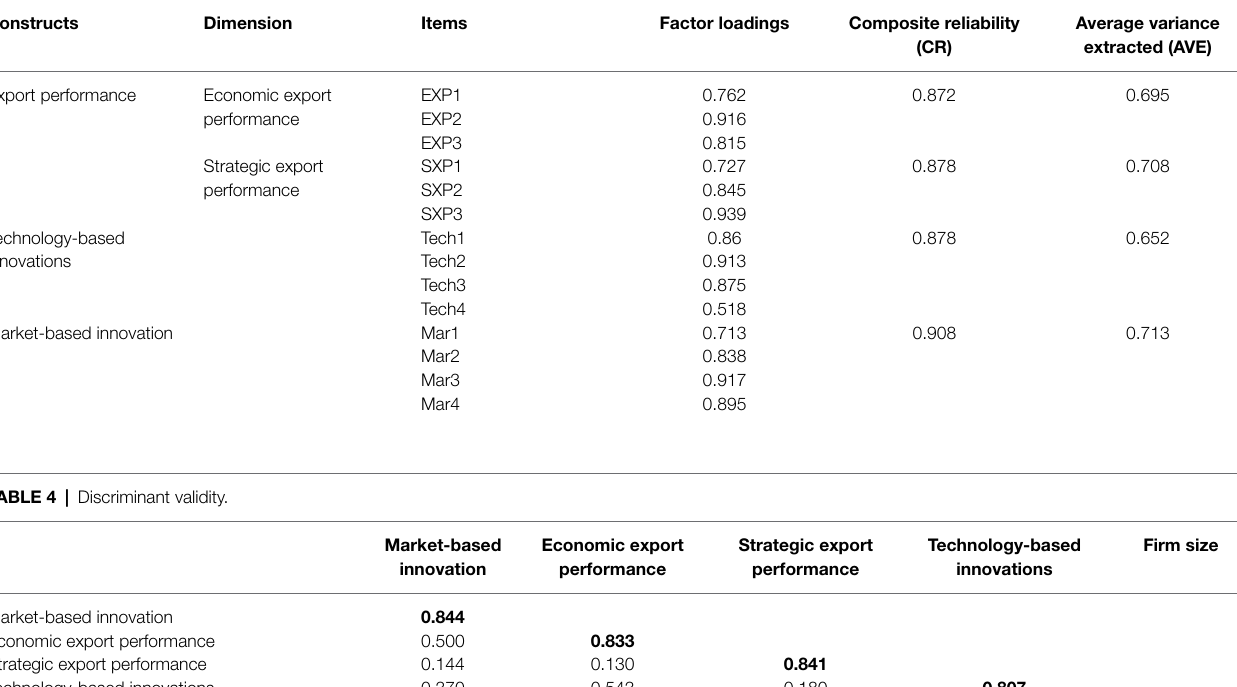
TABLE 3 | Convergent